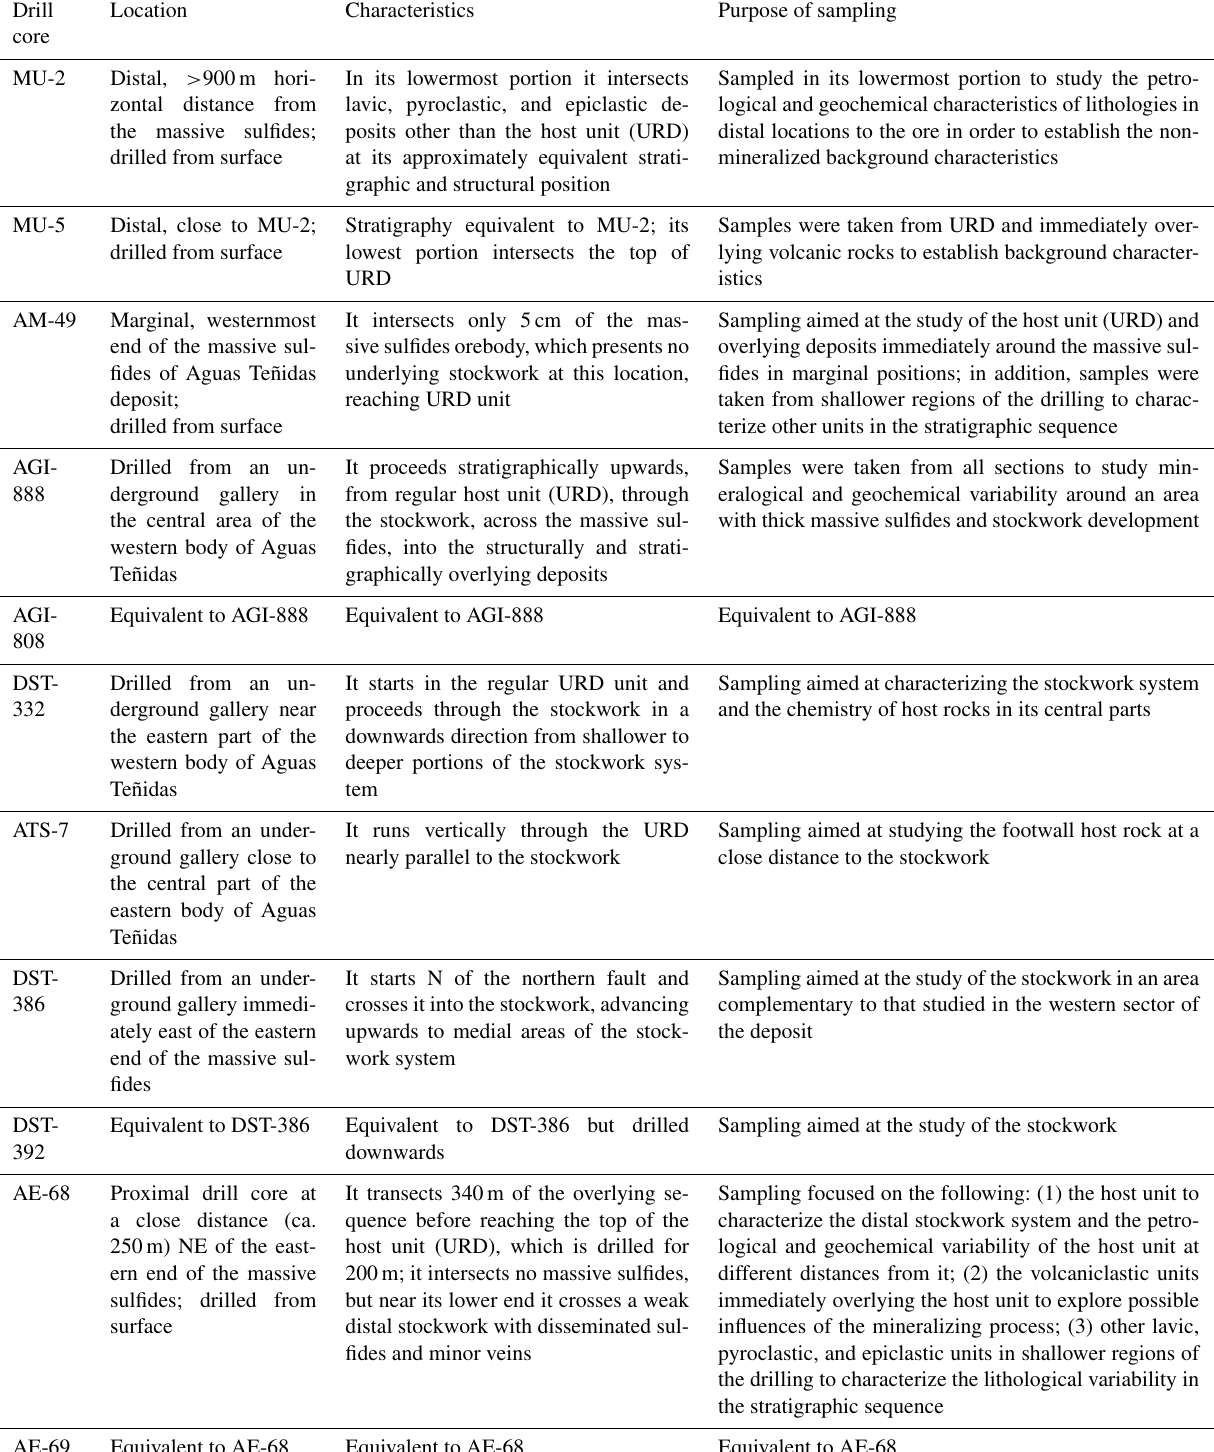
Table 2. Drill cores studied and sampled in this